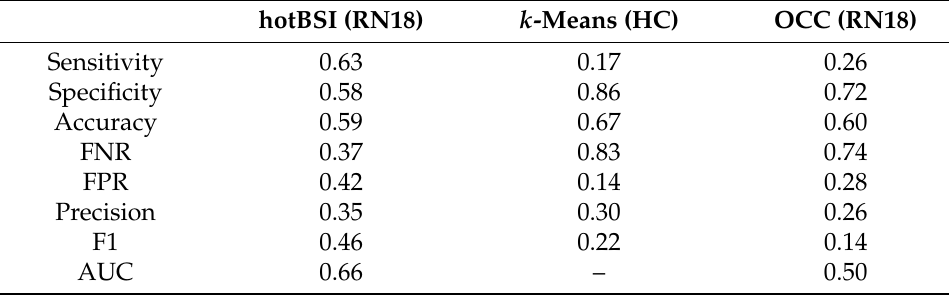
Table 7. Comparison of the best hotBSI with the best state-of-the-art